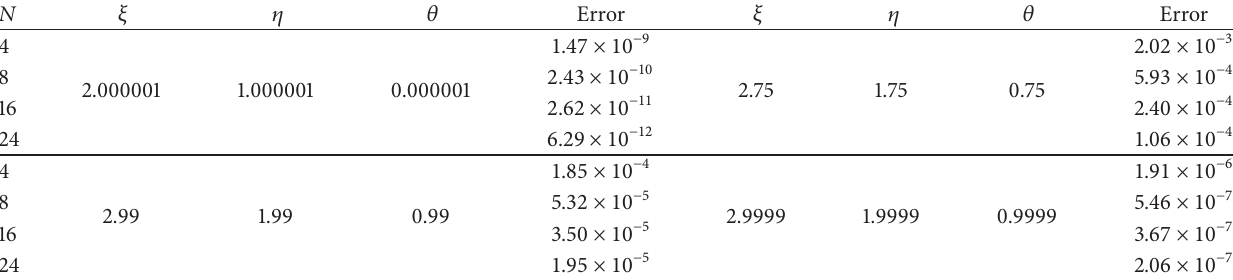
Table 2: Maximum absolute error for 𝛼 = 𝛽 = 1.5 and different choices of 𝜉, 𝜂, 𝜃 , and 𝑁